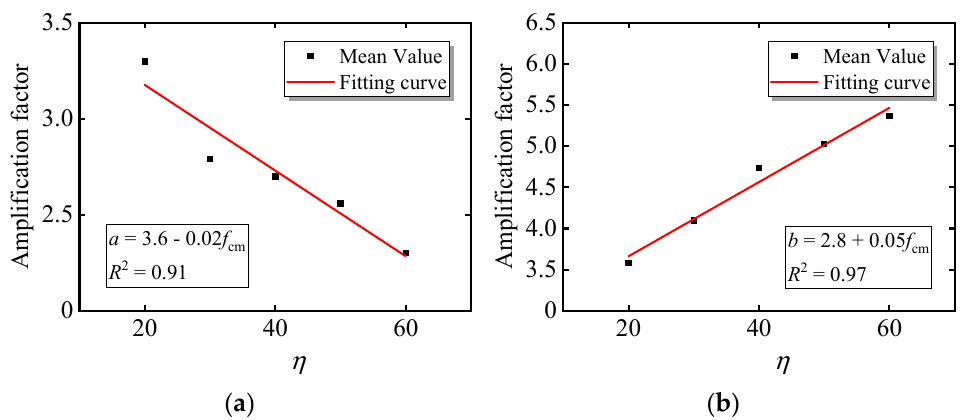
Figure 8. Power function correlation coefficient curve fitting: ( a ) coefficient a ; ( b ) coefficient b. Table 3. Power function coefficient value.